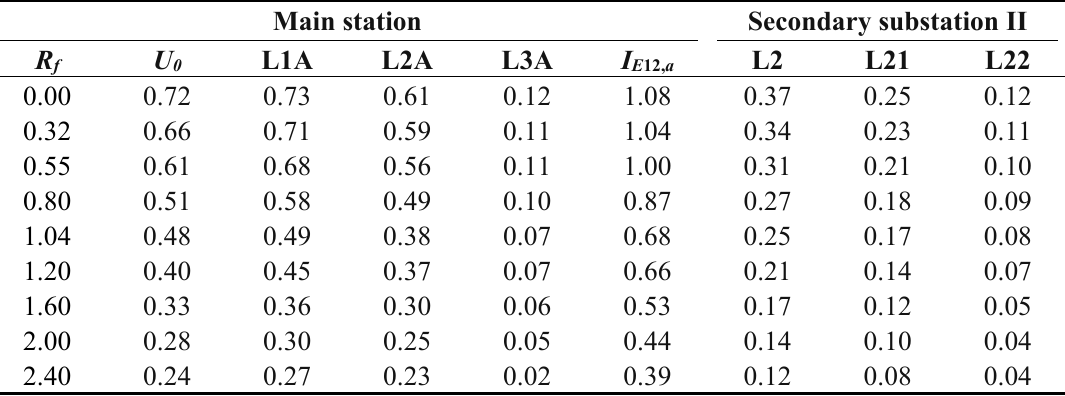
Table 9. Experimental results. Lines with and without load with different